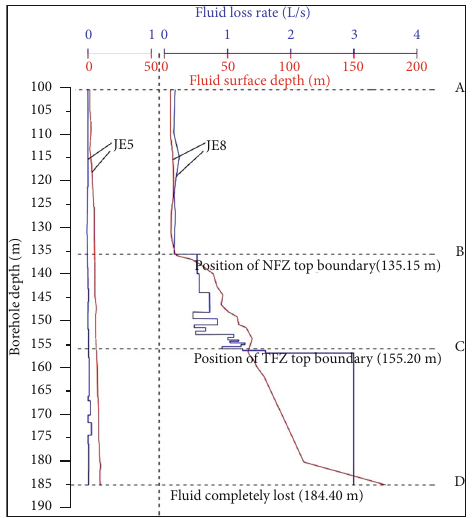
Figure 6: The change of drilling fl uid loss rate and fl uid surface depth in JE8